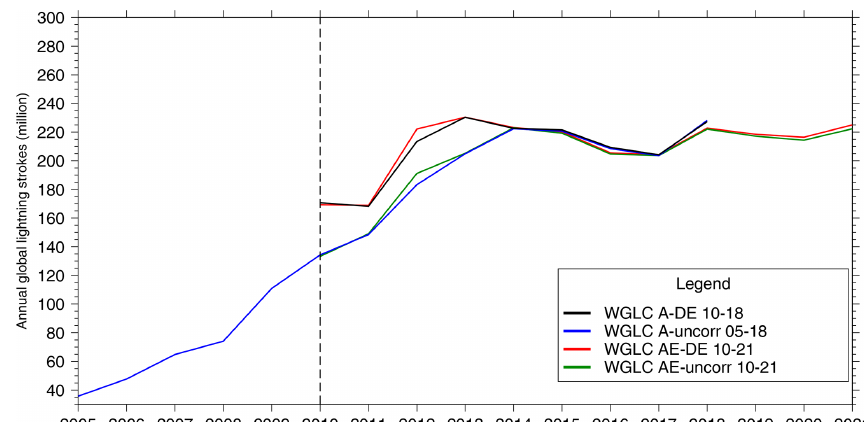
Figure 1. Total global lightning strokes from 2005 to 2021. WWLLN produces two sets of raw lightning stroke data: A (A-raw) and AE (AE-raw). The A-DE and AE-DE curves are adjusted for the WWLLN reported detection efficiency. Detection efficiency and AE data were produced starting in 2010. WWLLN “A” data (A-raw and A-DE) are shown for illustrative purposes and only up to